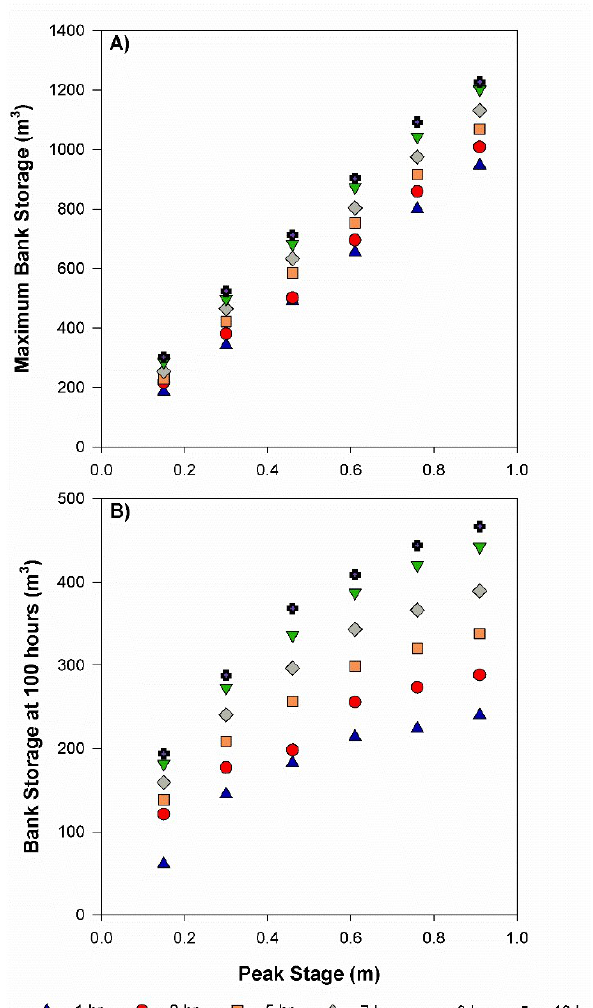
Figure 6. ( A ) Peak stage versus maximum bank storage and peak stage for all 36 numerical simulations, a positive relationship exists for all storm durations. ( B ) Relationship between peak stage and bank storage remaining at 100 h for all 36 numerical simulations.